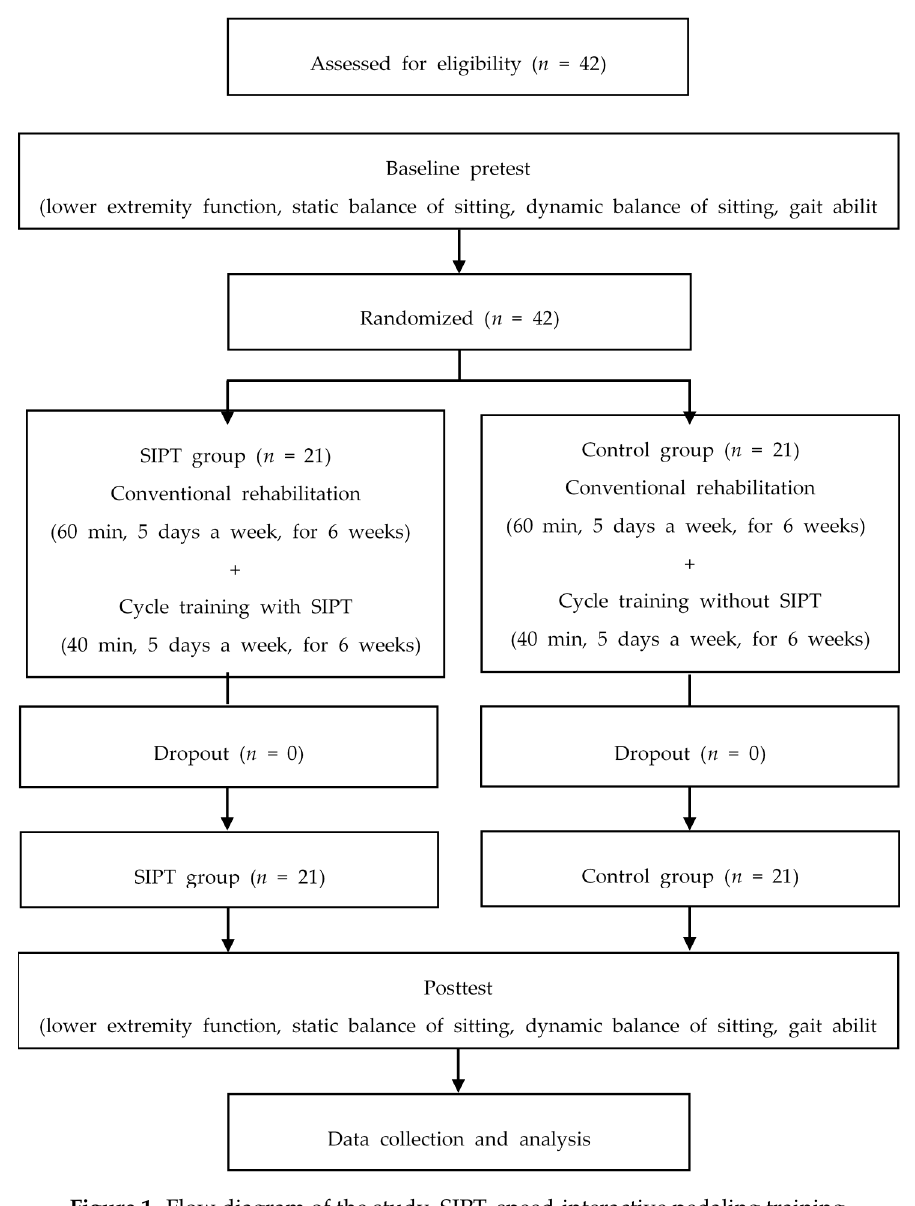
Figure 1. Flow diagram of the study. SIPT, speed-interactive pedaling